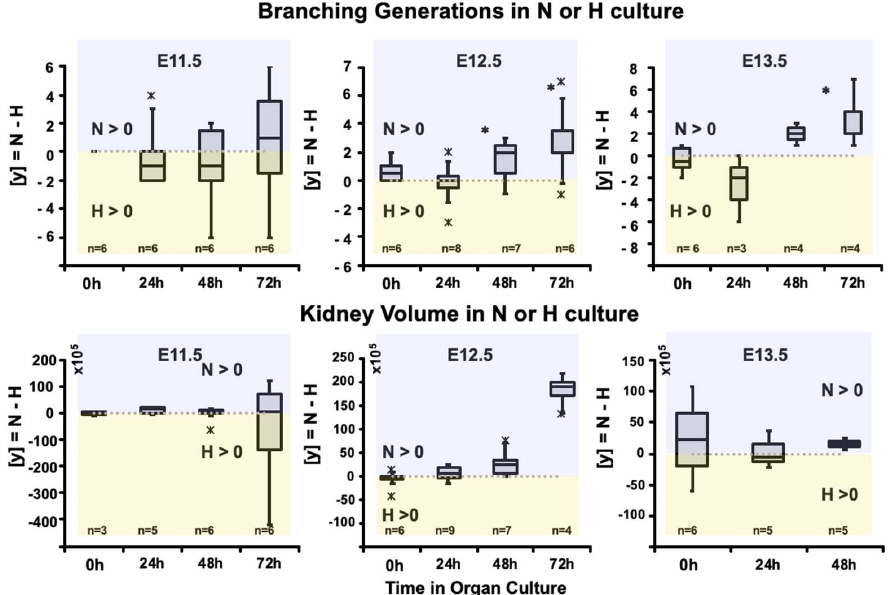
Figure 2. Branching generation and kidney volume. The upper panel shows the number of branching generations of embryonic kidneys harvested at E11.5, E12.5, and E13.5 after culture in normal (N) and hypoxic (H) condition. Branching generations are expressed in box plots as [y] = N − H at time points 0 h (fresh), 24 h, 48 h and 72 h. *: p < 0.05 Kidney volume ( y -axis) is expressed as voxel.